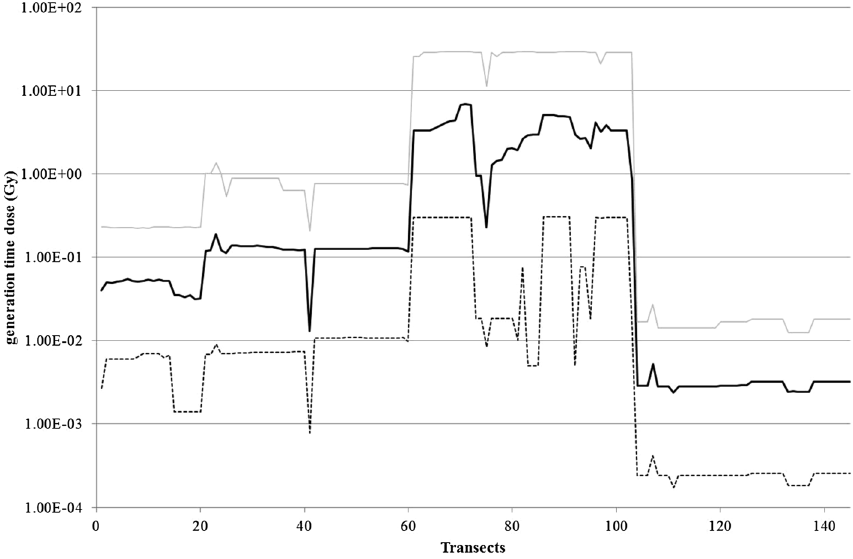
Figure 4. Generation time dose per transect (dotted and gray lines: extreme values among the 12 species; black line: geometric mean on the 12 species- TTD